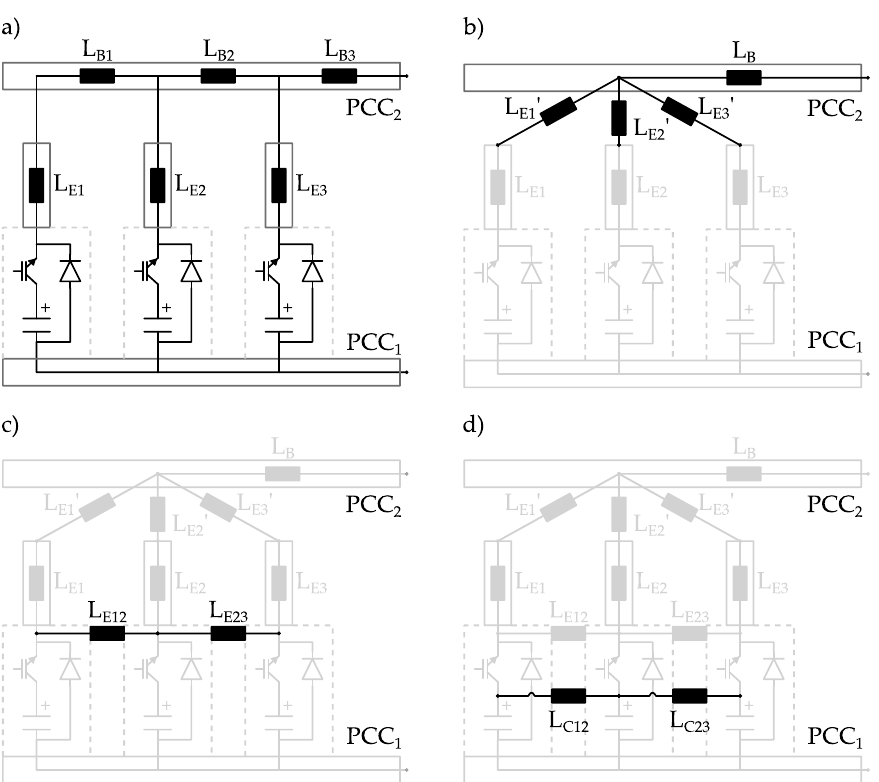
Figure 12. Setup of interconnection coordination for experimental investigations with ( a ) base case and ( b – d ) further developments. Highlighted elements are changes compared to the respective previous design.